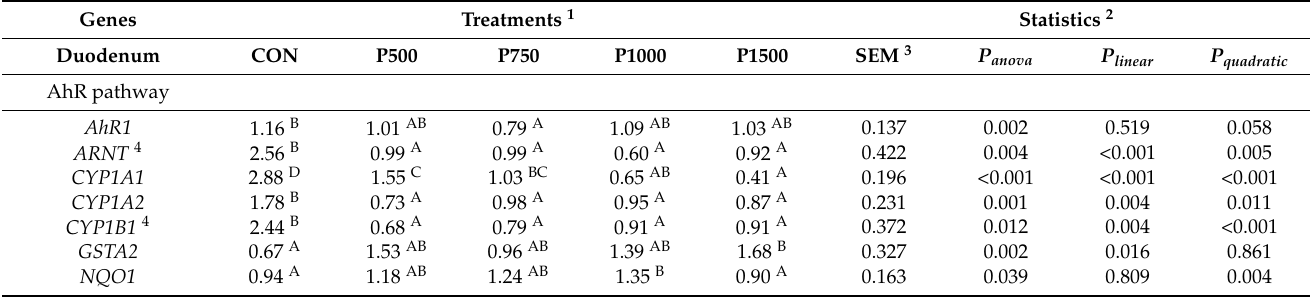
Table 5. Relative expression of the AhR pathway genes in the layers’ duodenum at the 12th week of the